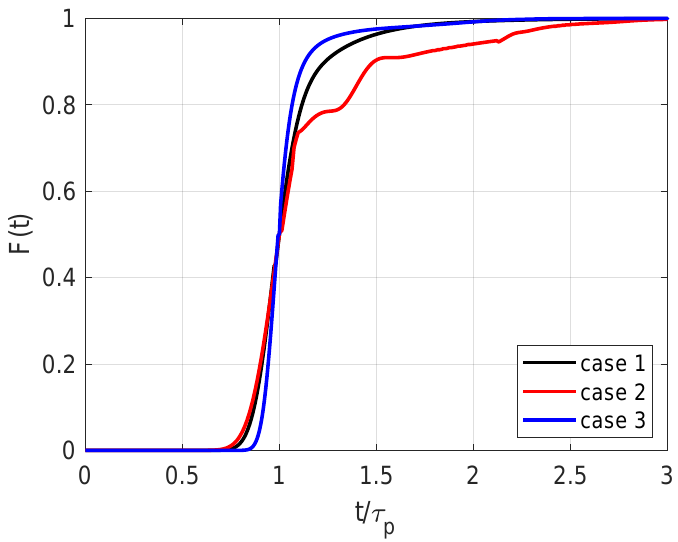
Figure 7. Cumulative distribution function F ( t ) for a step change in concentration of a non-reacting species at the system inlet (i.e., cases 1, 2 and 3 with R = 0 in Equation (12)).